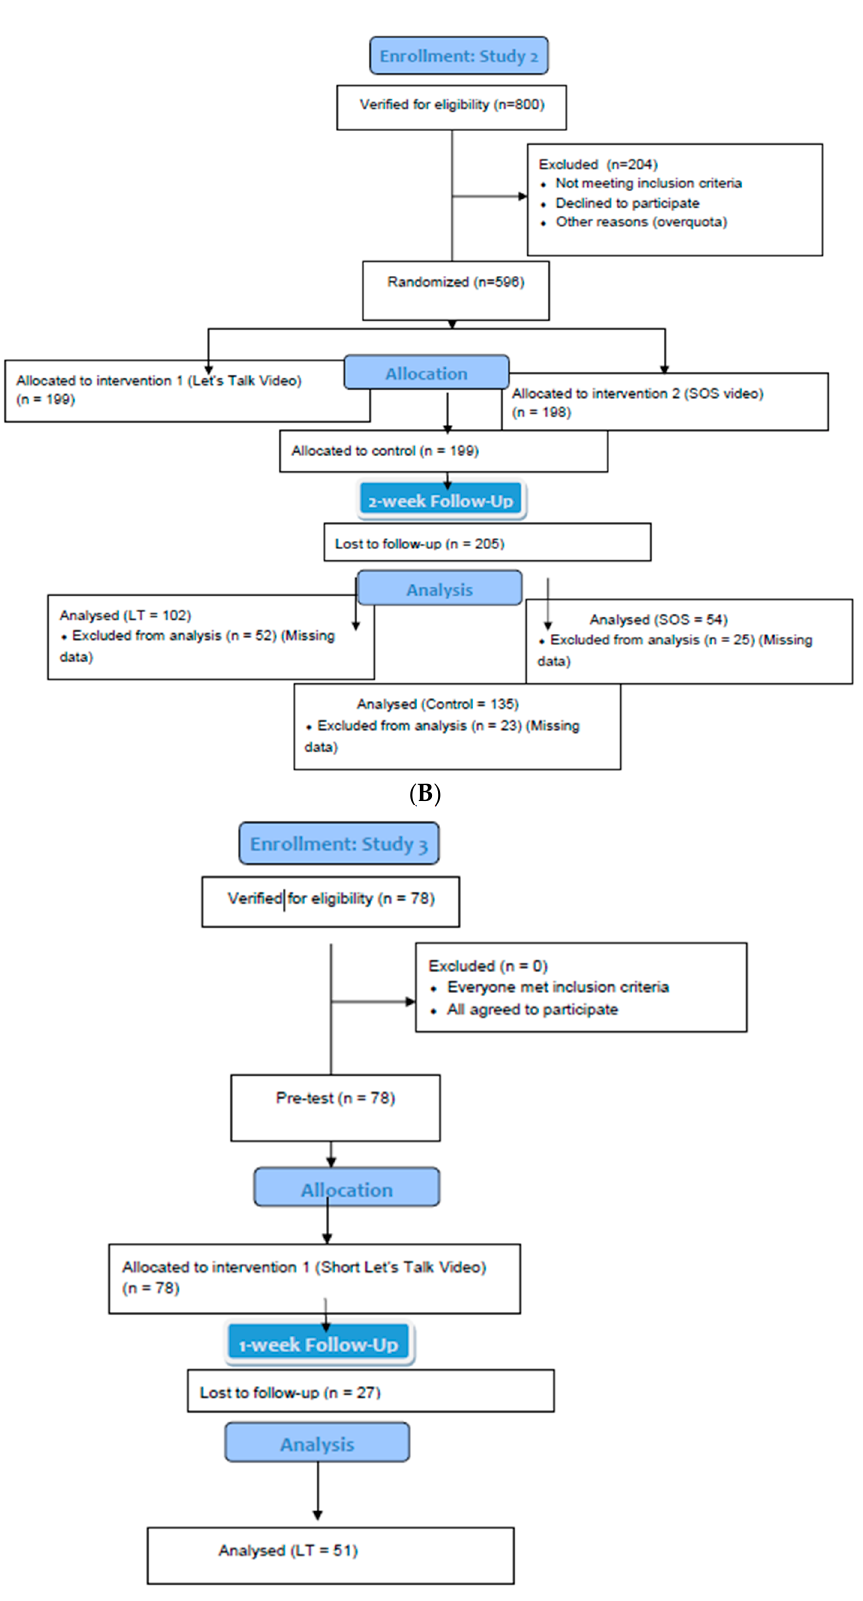
Figure 1. ( A ) Flow Diagram for Study 1; ( B ) Flow Diagram for Study 2; ( C ) Flow Diagram for Study 3. All of the above studies’ protocols were approved by the Montana State University Billings Institutional Review Board (IRB00001622).